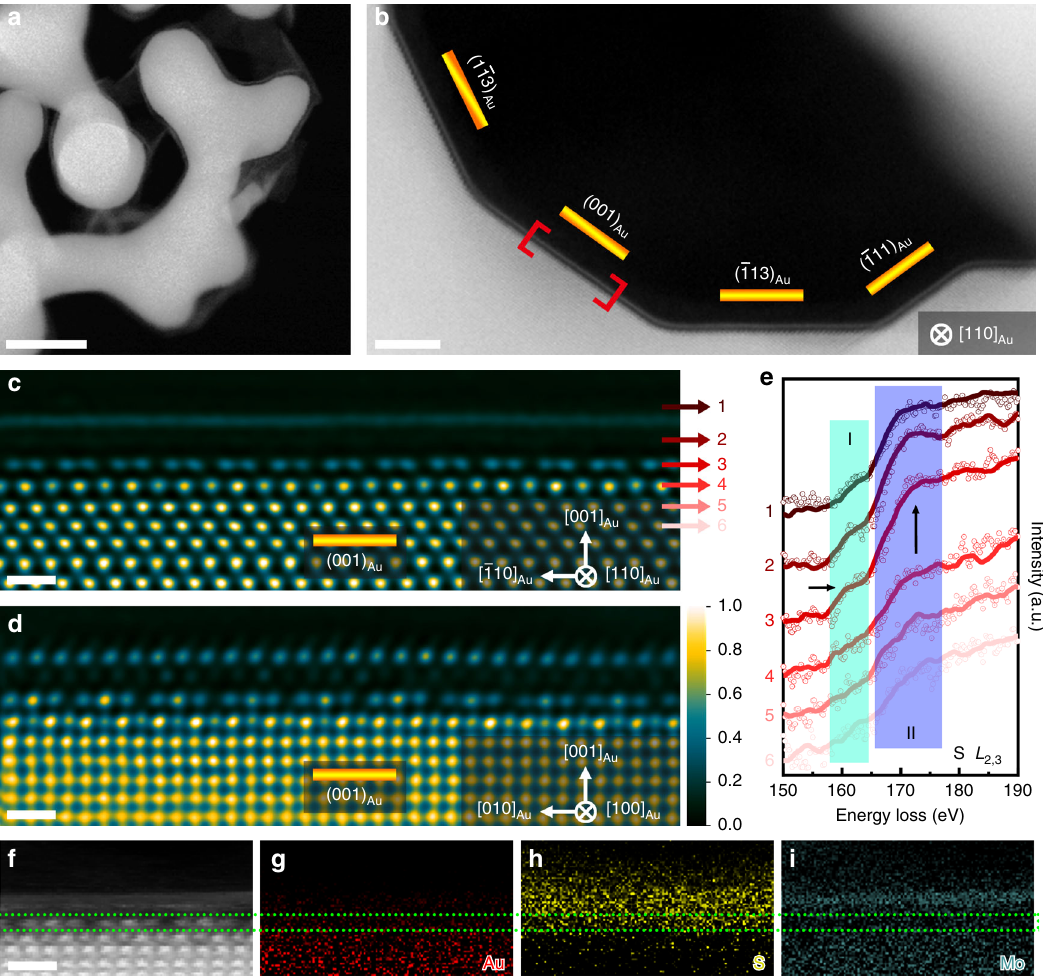
Fig. 1 Structural and chemical characterization of the interface between monolayer MoS 2 and NPG. a Low magni fi cation HAADF-STEM image of the MoS 2 fi lm grown on NPG. Scale bar, 50 nm. b Magni fi ed HAADF-STEM image of monolayer MoS 2 grown on the internal surfaces of NPG. Scale bar, 5 nm. c , d Filtered HAADF-STEM images viewed from the [110] Au ( c ) and [100] Au ( d ) directions. Color variation from black to blue and then to yellow corresponds to the intensity from low to high. Scale bar, 0.5 nm. e EELS spectra of S L 2,3 core-level edges summed from the different layers of MoS 2 and Au in ( c ). f – i EELS elemental mappings of Au ( g ), S ( h ) and Mo ( i ) and simultaneous HAADF-STEM image ( f ) of monolayer MoS 2 on Au (001) surface. Scale bar, 0.5